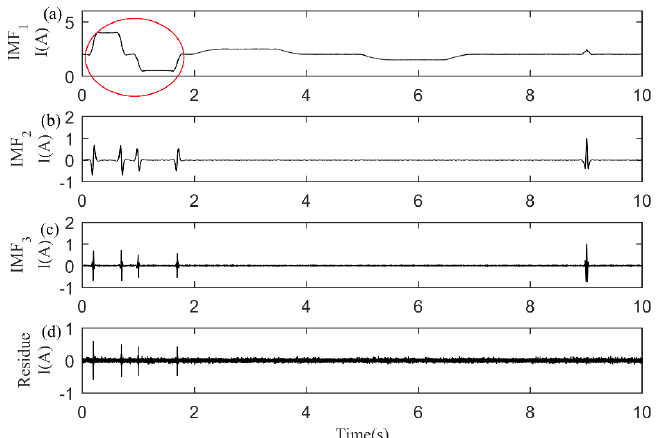
Figure 7. VMD simulation signal decomposition results. ( a ) IMF 1 component; ( b ) IMF 2 component; ( c ) IMF 3 component; ( d ) Residue.